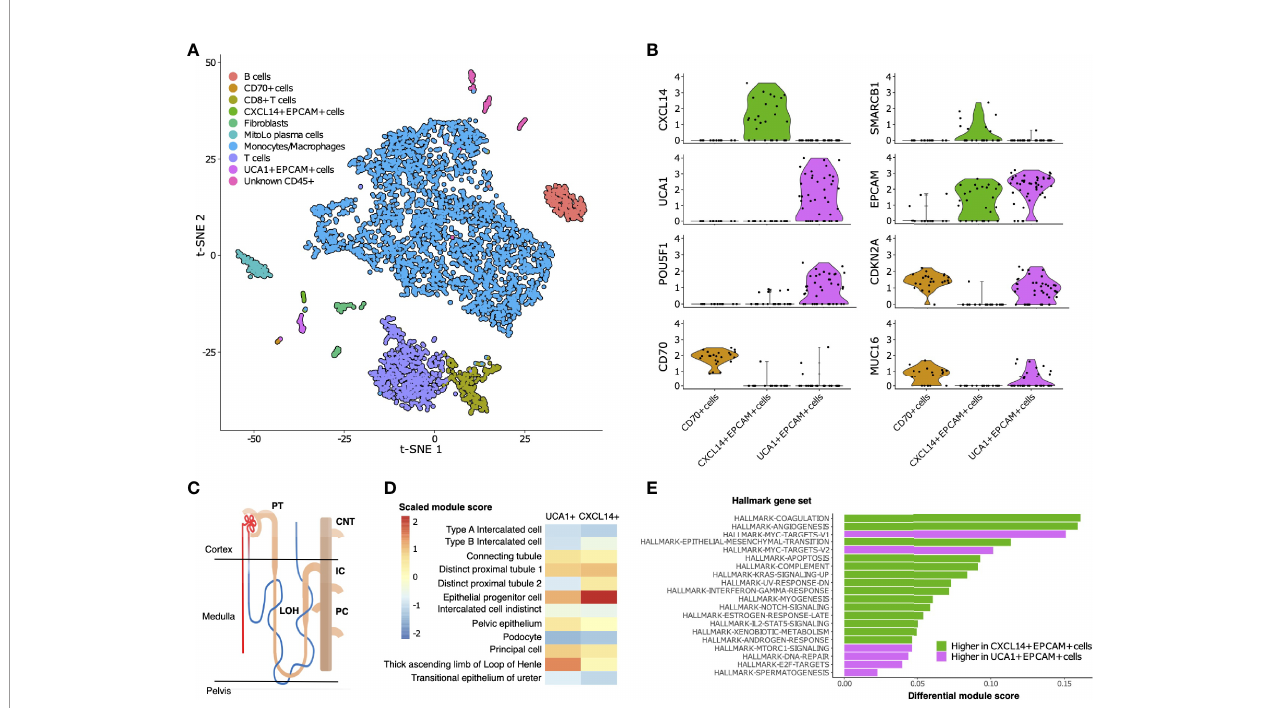
FIGURE 2 | Single-cell composition of RMC. (A) t-SNE embedding of transcriptional pro fi les from all cells (n = 5610). Each dot represents a single cell and colors represent clusters denoted by inferred cell type. (B) Normalized log 2 expression of a selection of genes characterizing the three sub-clusters of epithelial-like cells as described in main text. Violin plot top and bottom lines indicate range of normalized expression; width indicates number of cells at the indicated expression level. Test statistics for each gene that was signi fi cantly differentially expressed in a given sub-cluster are reported in main text. (C) Anatomy of the human nephron with site of origin for various cell types. PT, proximal tubule; CNT, connecting tubule; LOH, Loop of Henle; IC, intercalated cells; PC, principle cells. (D) Module scores (scaled) corresponding to gene set signatures of various epithelial cell types from the mature human kidney for UCA1+ and CXCL14+ epithelial-like clusters. (E) Differential module scores corresponding to hallmark gene set signatures as calculated between UCA1+ and CXCL14+ epithelial-like